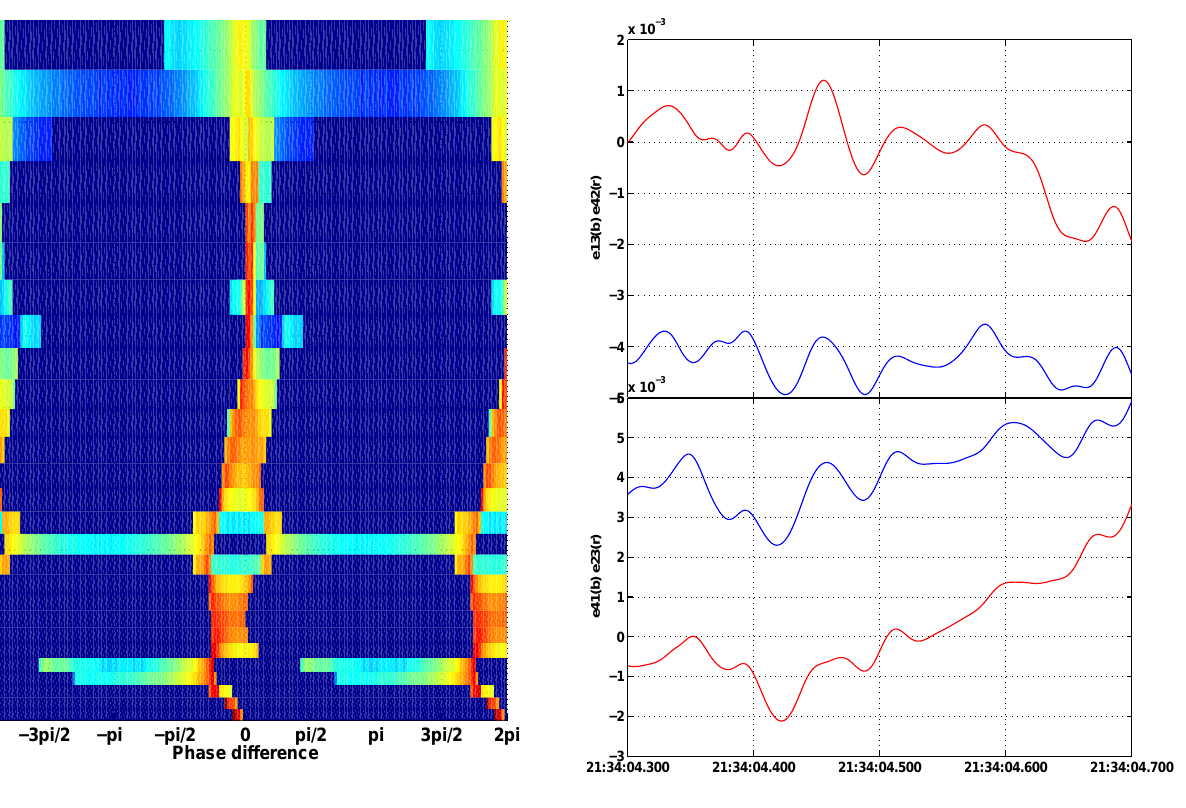
Fig. 9. The electric field waveforms E 13 and E 42 (top panel) and E 41 and E 23 (lower panel) for the second